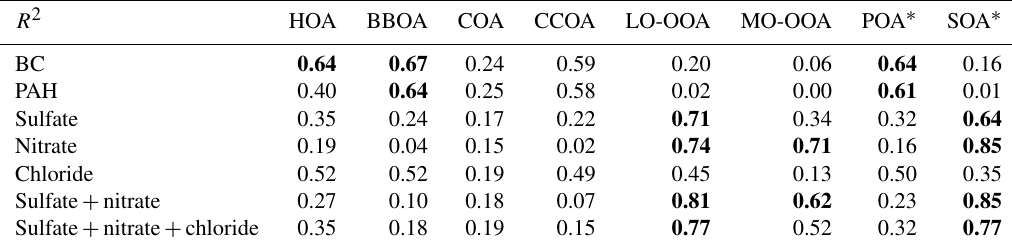
Table 2. Coefficient of determination ( R 2 ) between time series of OA factors and other aerosol species. Values indicating a strong correlation (i.e., R 2 > 0 . 6) are in bold. R 2 HOA BBOA